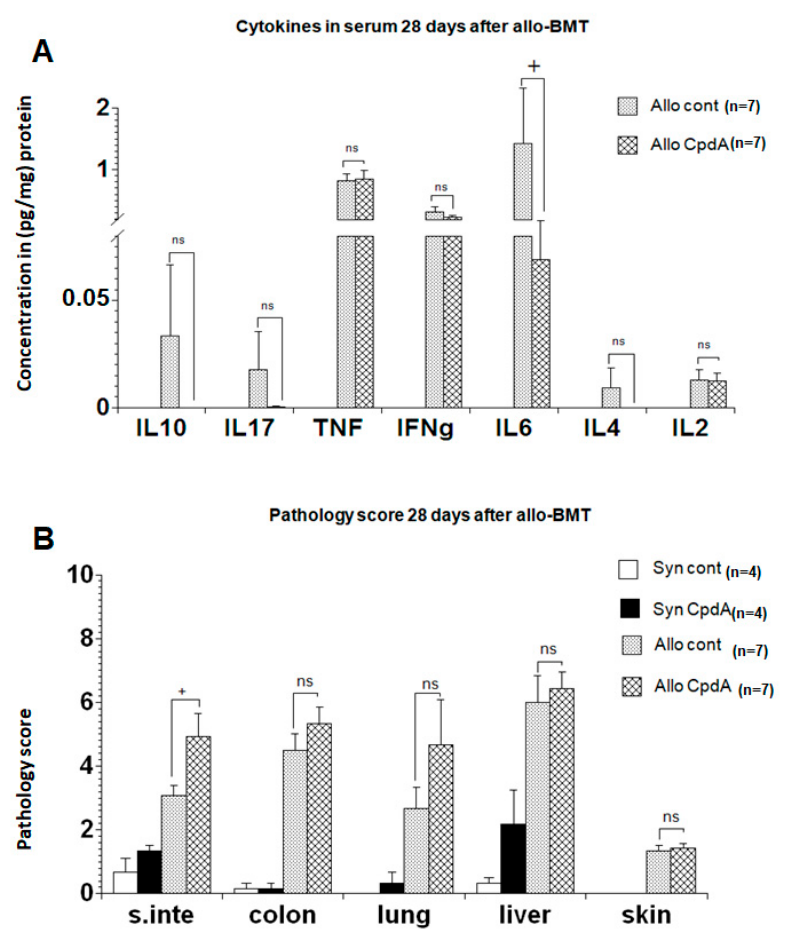
Figure 3. Cytokine expression and pathology score. Lethally irradiated B6D2F1 mice were trans- planted as described in the Materials and Methods section and treated intraperitoneally thrice